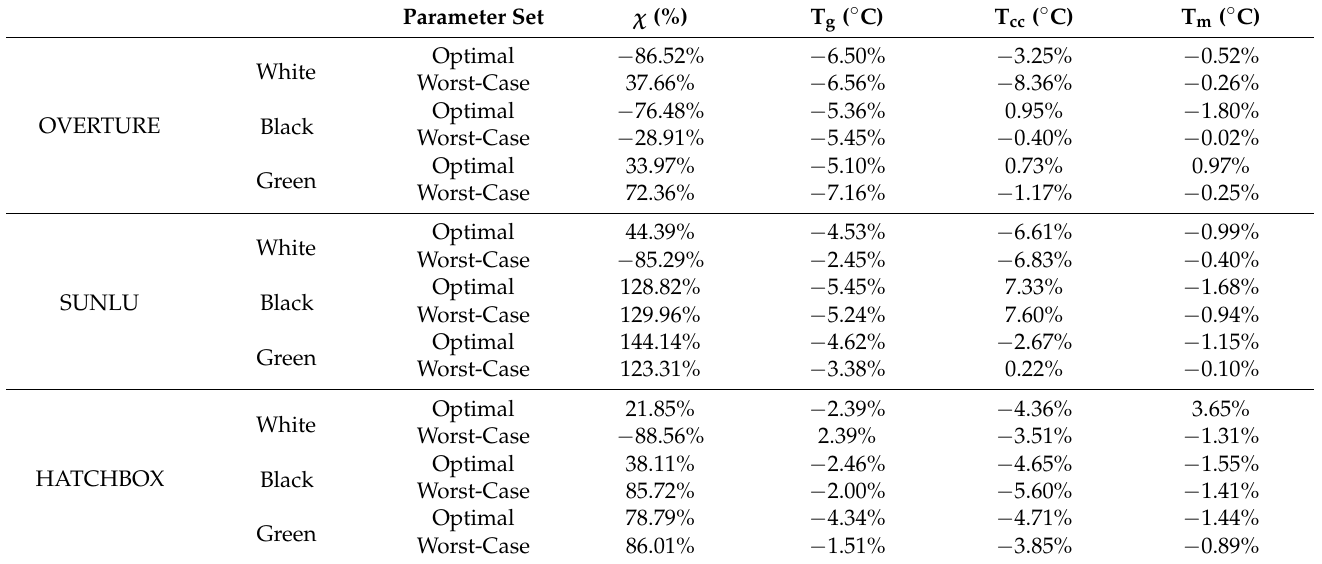
Table 9. Percent differences in thermal characteristics (with original units provided) between the annealed and as-printed specimens for each filament for both the optimal and worst-case parame- ter